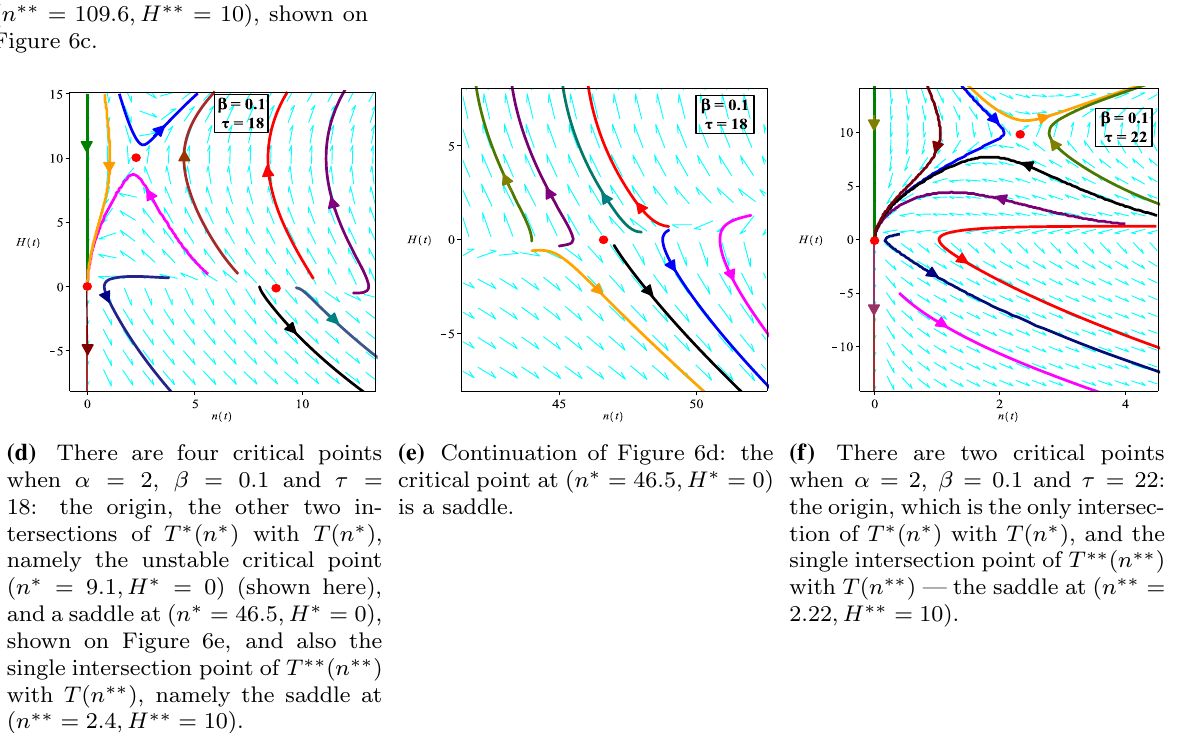
= 5 . 83 are with real eigenvalues with with 0 < n ∗∗ < n ∗∗ 1